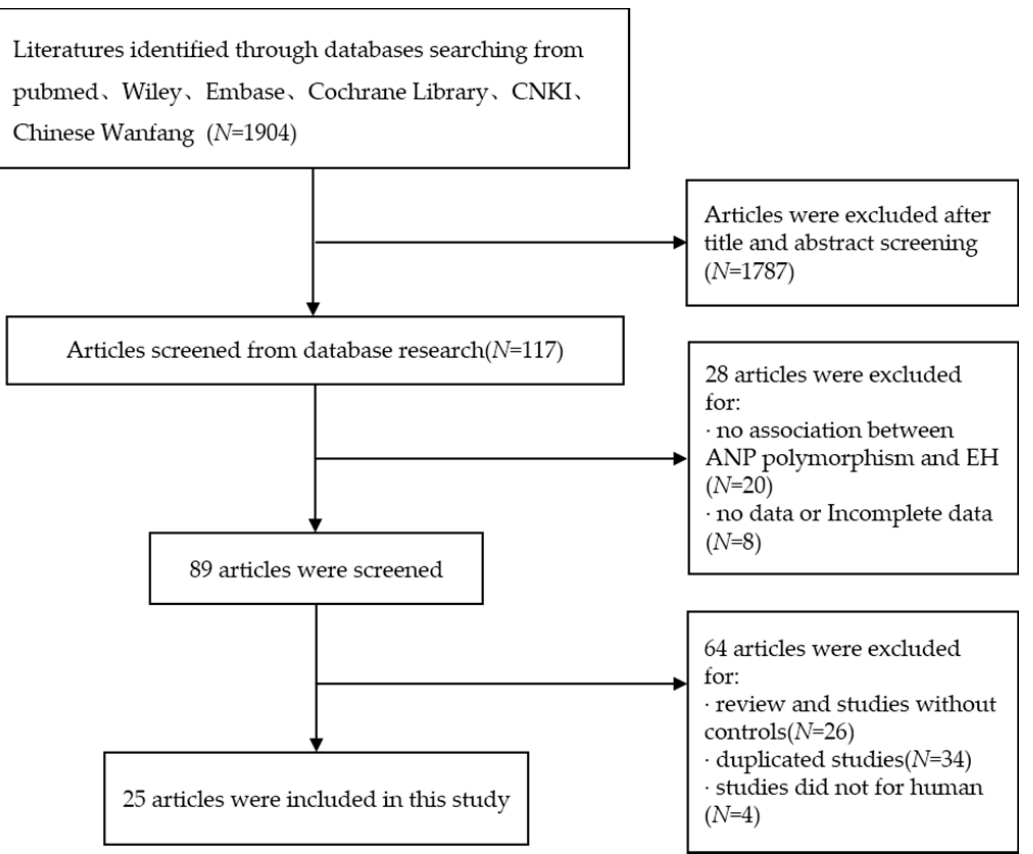
Figure 1. Flow chart of studies included in this meta-analysis.